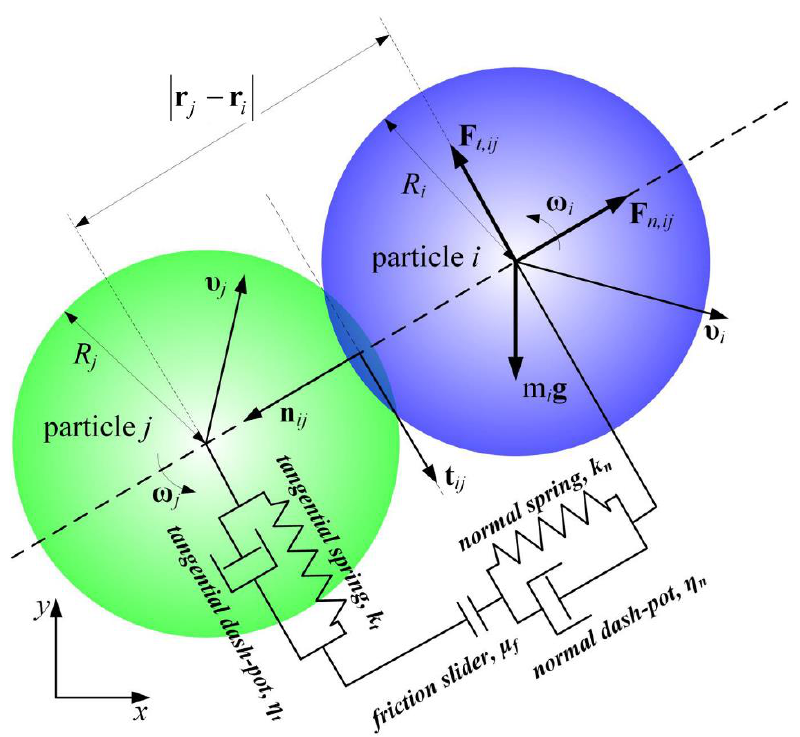
Figure 2. Schematic illustration of the contact force model between particles i and j . Table 1. The specific formula for each force and torque acting on particle i